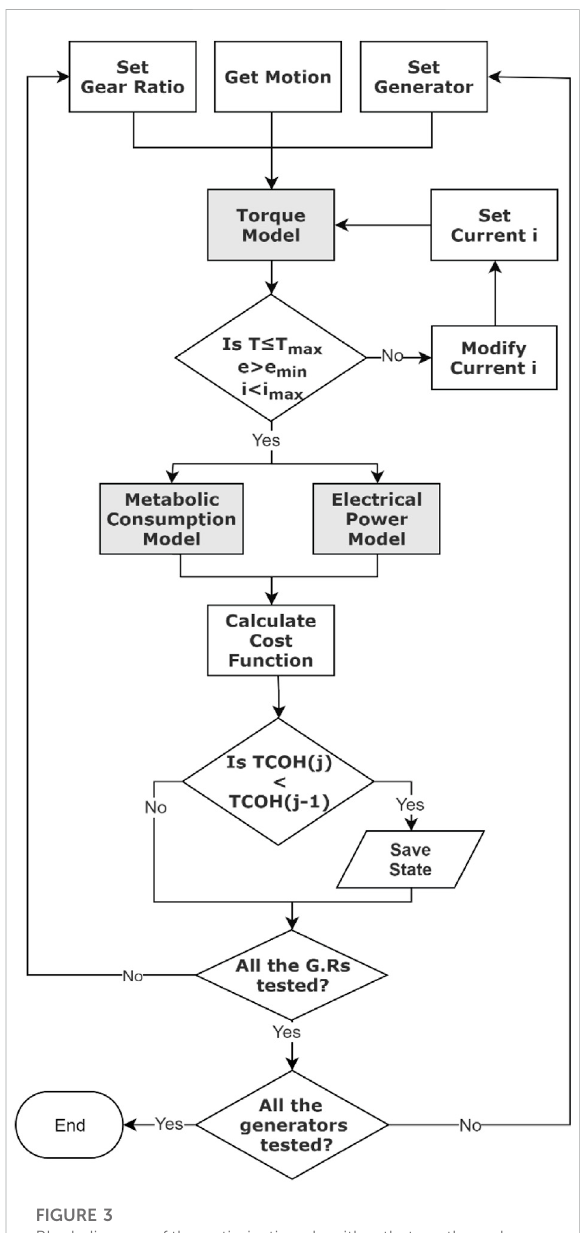
FIGURE 3 Block diagram of the optimization algorithm that ran through all the states and found the best